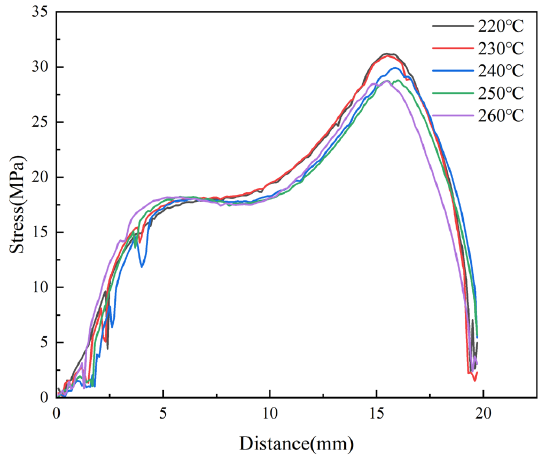
Figure 19. Variations of stress curves at different melt temperatures along the centerline of the parts.